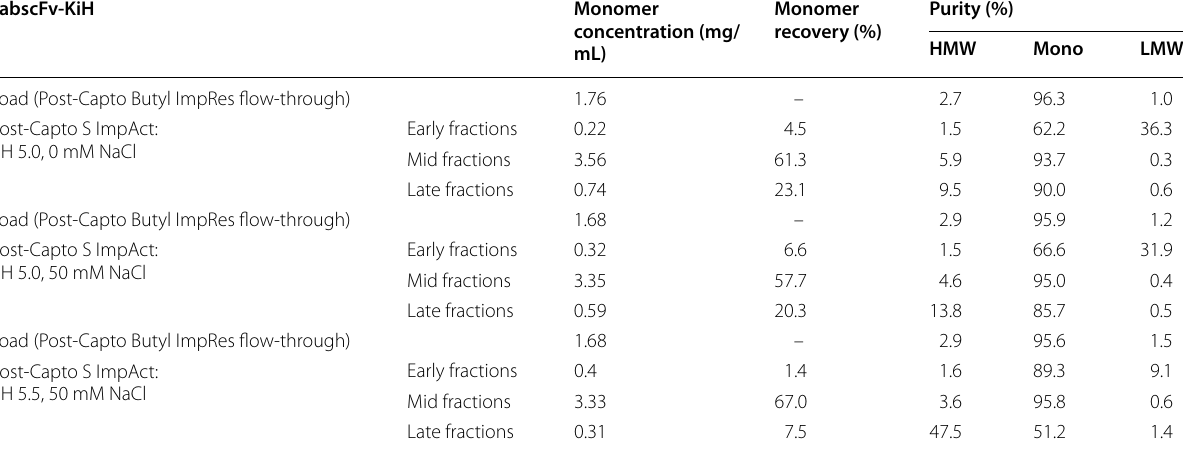
Monomer Purity (%) concentration (mg/ recovery (%) HMW Mono LMW mL)